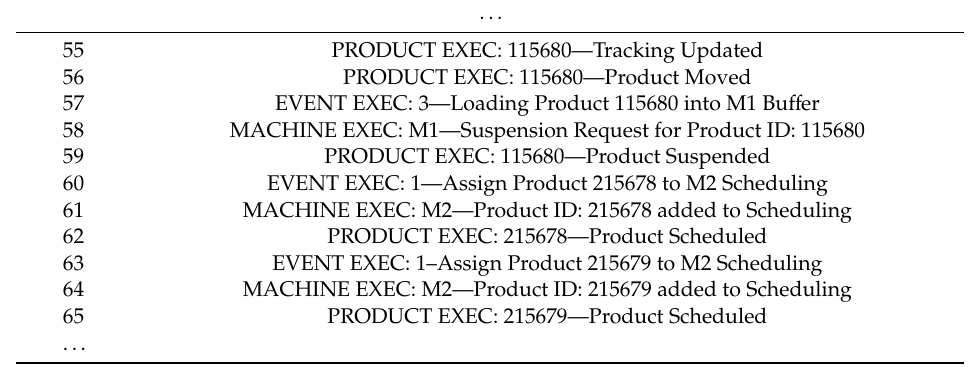
Table 7. Extract of simulation log with the messages of the agents related to the Machine Overloading Scenario.